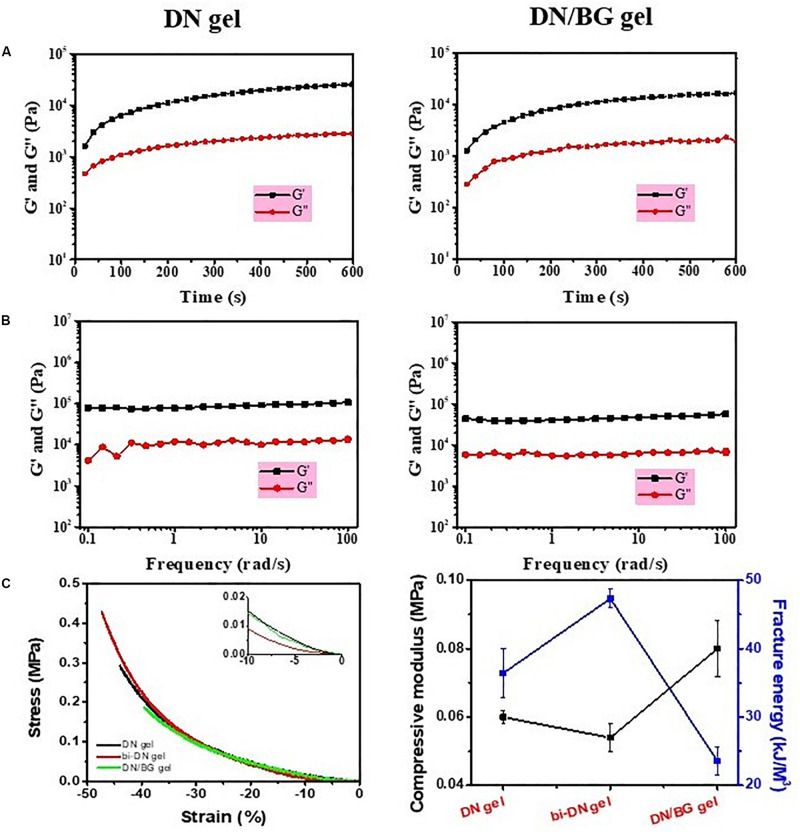
(A) Time sweeping and (B) frequency sweeping curves of DN gel and DN/BG gel; (C) Compressive properties of DN, bi-DN and DN/BG gels.